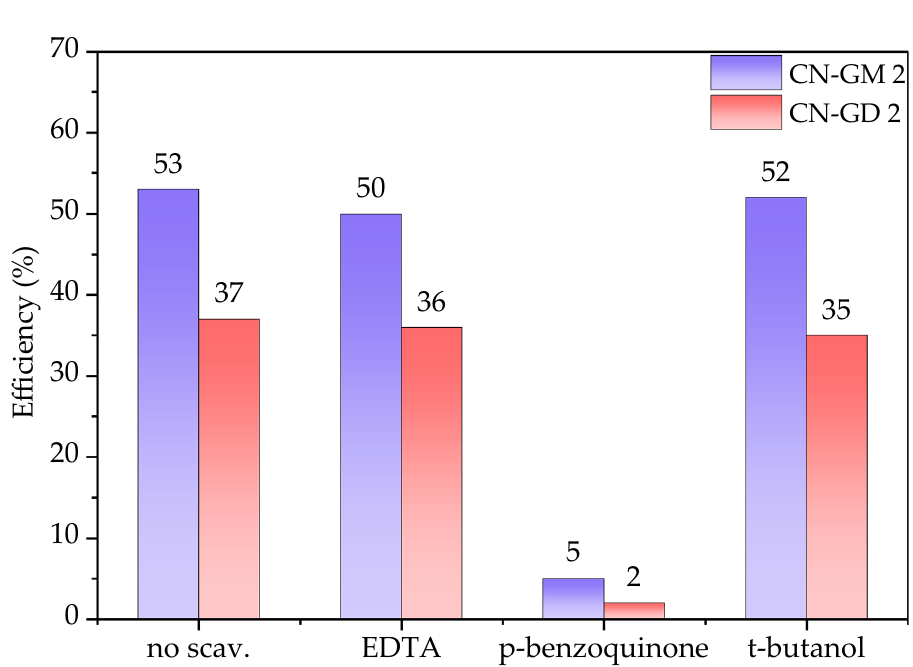
Figure 7. Photocatalytic decomposition of RhB in the presence of CN-GM 2 and CN-GD 2 using scavengers of holes (EDTA), superoxide radicals (p-benzoquinone) and hydroxyl radicals (t-butanol). The decomposition time was 120 min. The RhB concentration was 10 mg L −1